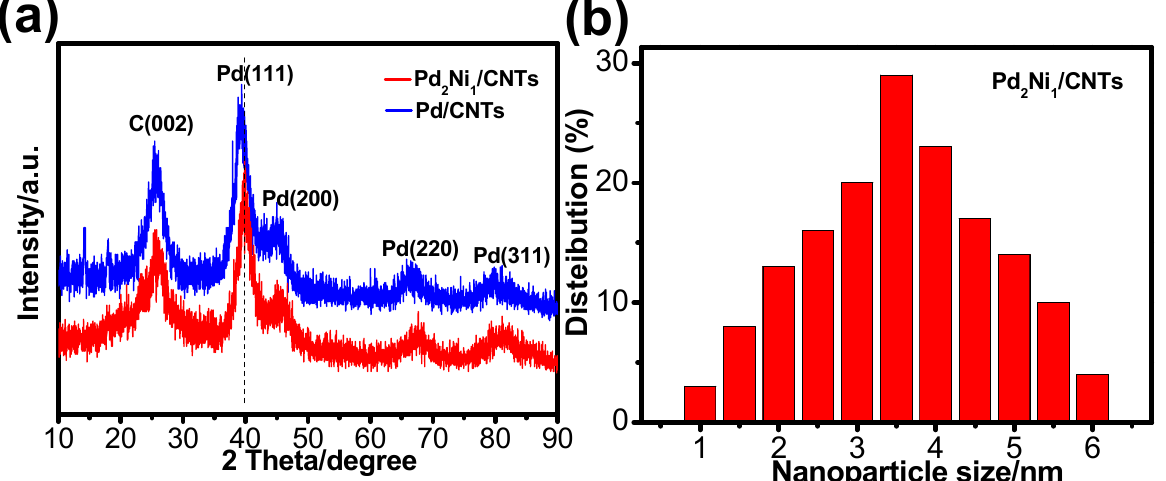
Figure 1. ( a ) XRD patterns of Pd/CNTs and Pd 2 Ni 1 /CNTs catalysts; ( b ) the corresponding particle size distribution of Pd 2 Ni 1 /CNTs.